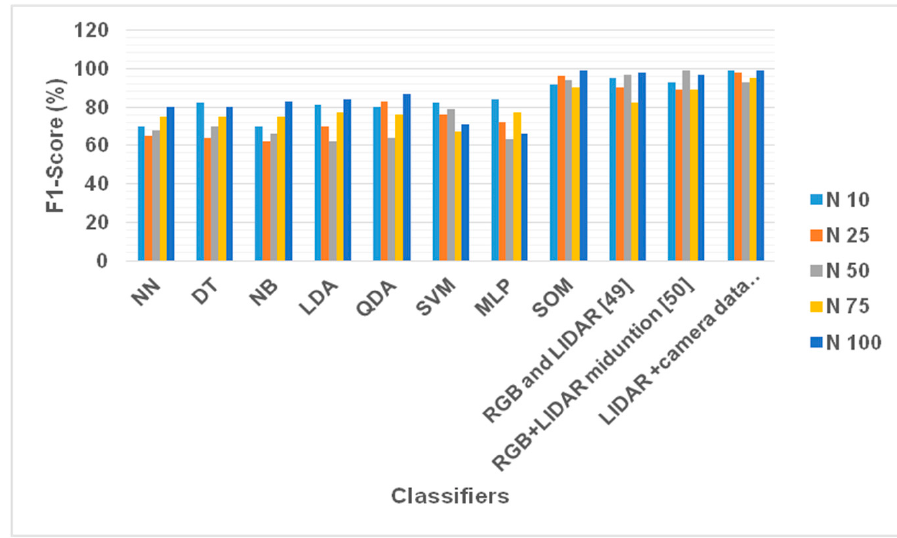
Figure 16. Comparison of F1-score.